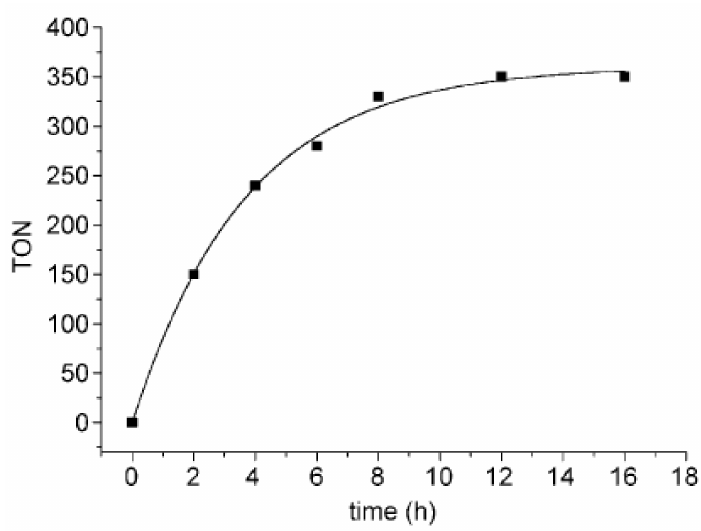
Figure 4. Effect of reaction time on acetylene hydrocarboxylation. Reaction